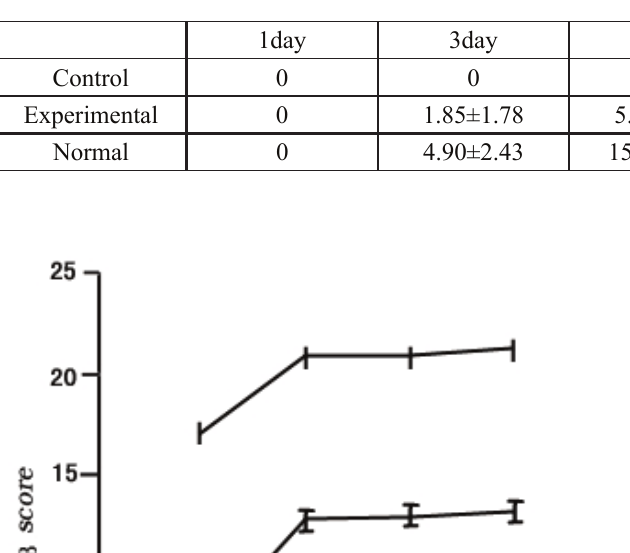
TABLE 1 - Mean BBB score of hindlimb movement after spinal cord hemisection at different time point.